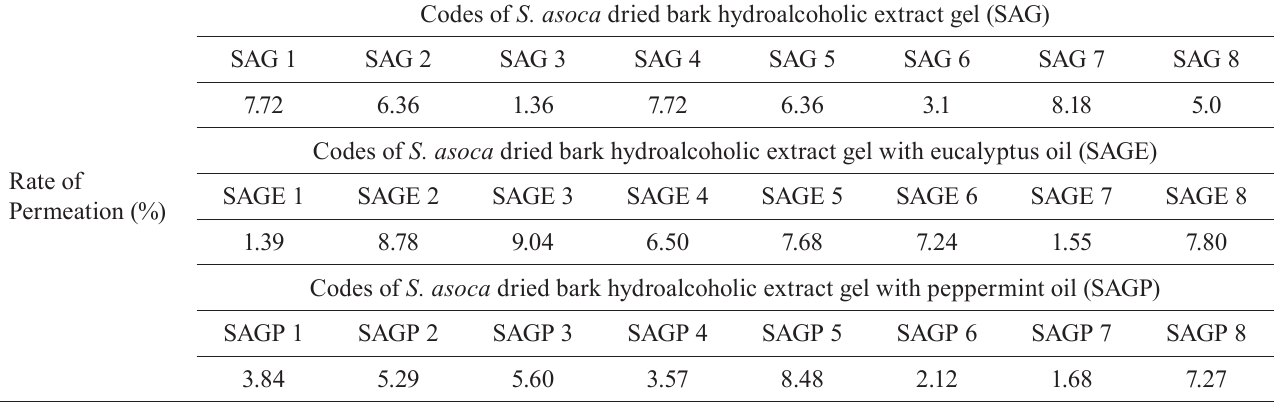
TABLE III - Permeability study results of SAG, SAGE and SAGP